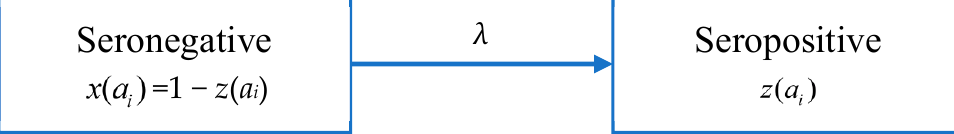
According to Muench’s catalytic model [48], people in age group i changes from a seronegative group to a seropositive group after infection at a rate λ , as shown in Figure 2. Here λ is used to denote FOI, and the proportions of seronegative and seropositive in the age group i are x(a i ) and z(a i ) , respectively. Figure 2. Model A: the catalytic model that assumes constant FOI without antibody decay.